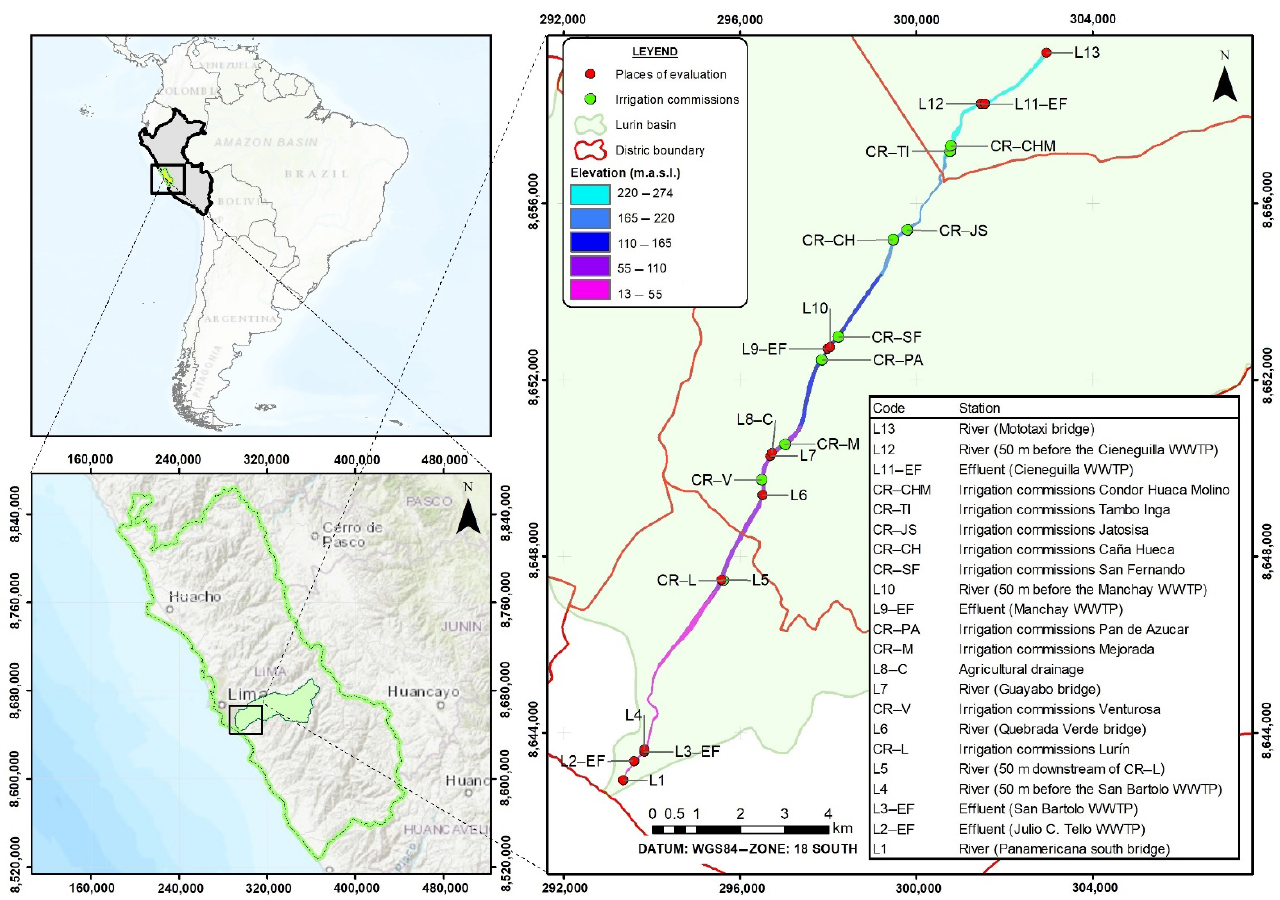
Figure 1. Geographical location of the evaluation stations and the intakes of the irrigation commis- sions in the lower part of the Lur í n